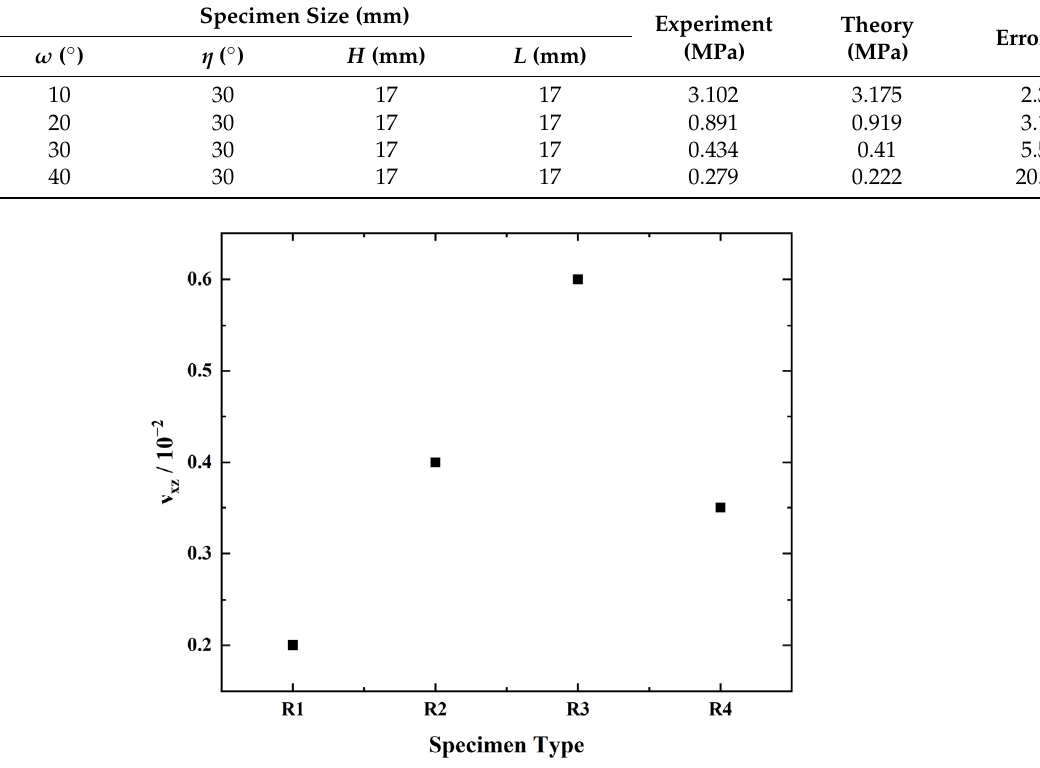
Figure 10. Experimental test results of Poisson’s ratio of 3D ZPR honeycomb.